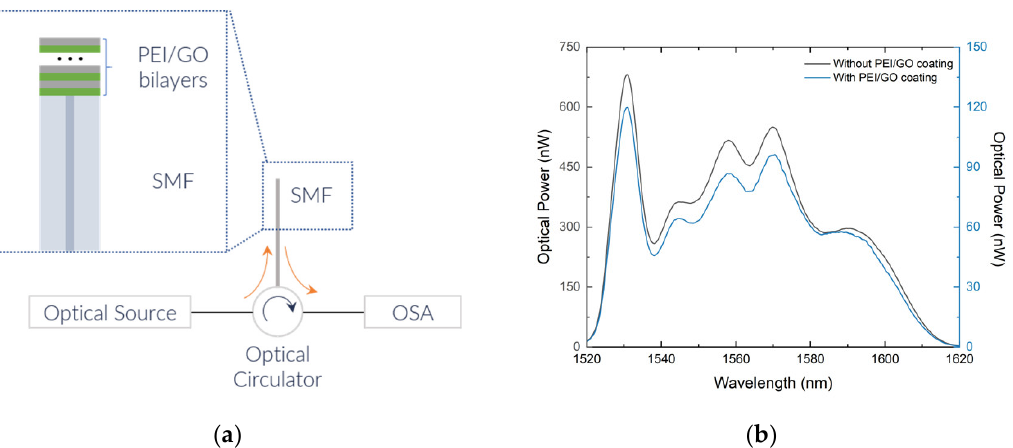
Figure 1. ( a ) Schematic of the experimental configuration used to measure the reflected optical signal power of the cleaved fibers possessing a (PEI/GO) 12 LbL film adsorbed on its cross section. ( b ) Reflected optical spectra of a (PEI/GO) 12 coated optical fiber and of a cleaved optical fiber with no coating. (PEI/GO) 12 : polyethyleneimine/graphene oxide layer-by-layer films prepared with 12 bilayers; SMF: single-mode optical fiber; OSA: optical spectrum analyzer.